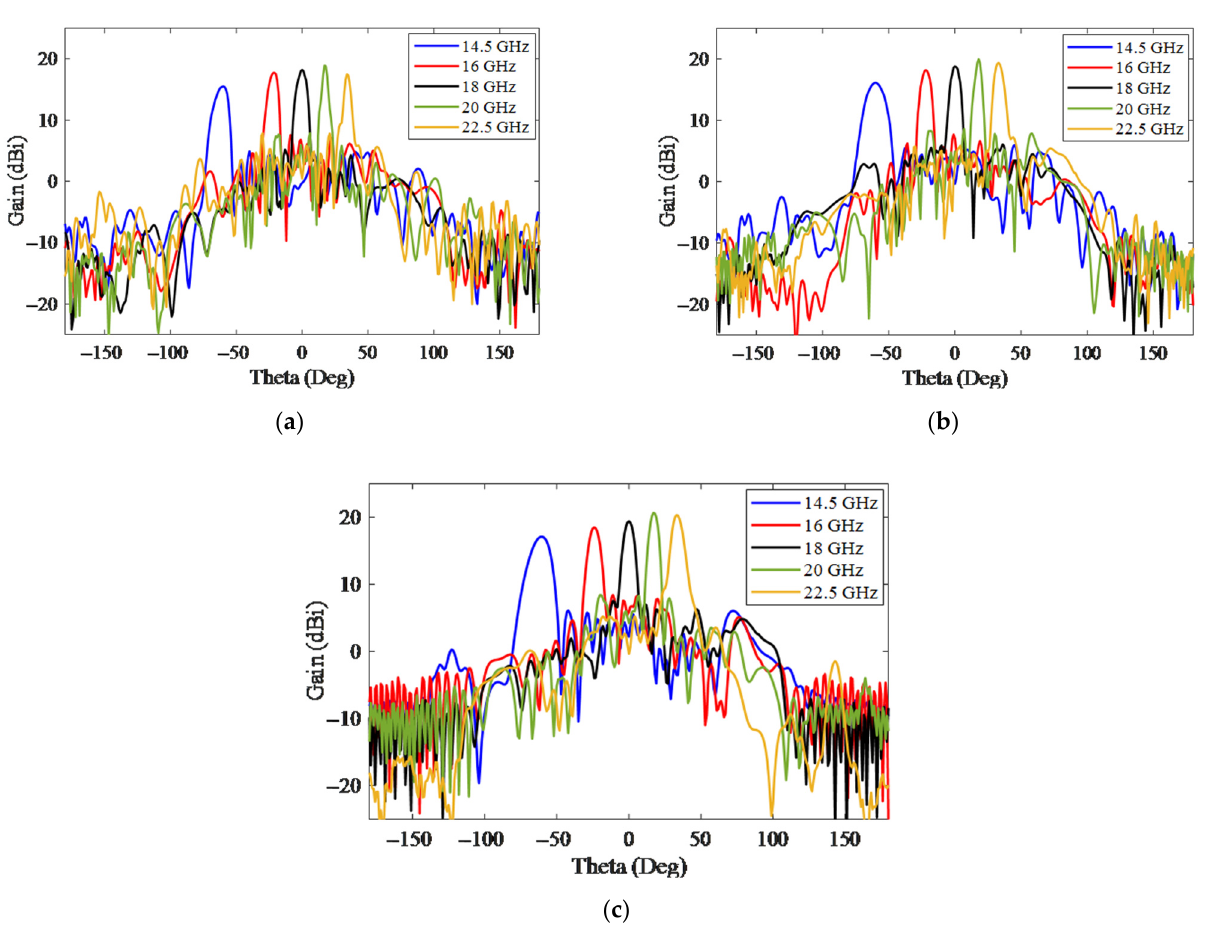
Figure 9. The simulated gain of the 2D-MBA for the excitation of different beam ports at 18 GHz. direction. The peak points of these 60 patterns for different ports and different frequencies are reported in Table 2.